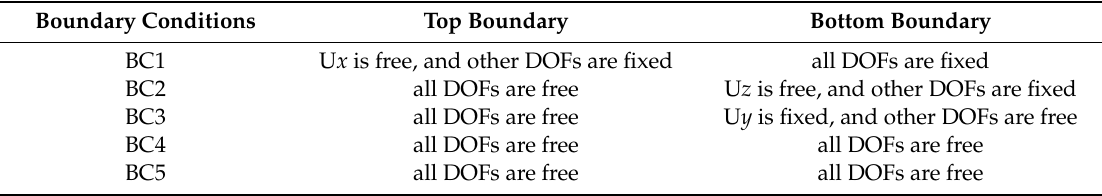
Table 1. The degree of freedoms (DOFs) under five boundary conditions. (U x , U y and U z represent the DOFs along the x, y , and z directions,